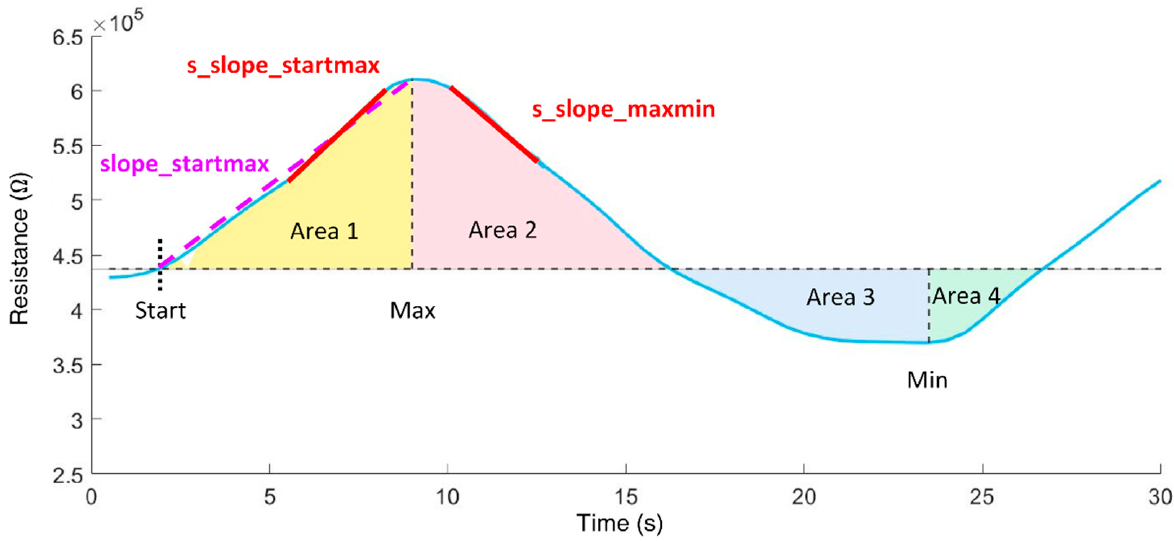
Figure 4. Time domain features extracted from the resistance curve of an exhalation cycle.